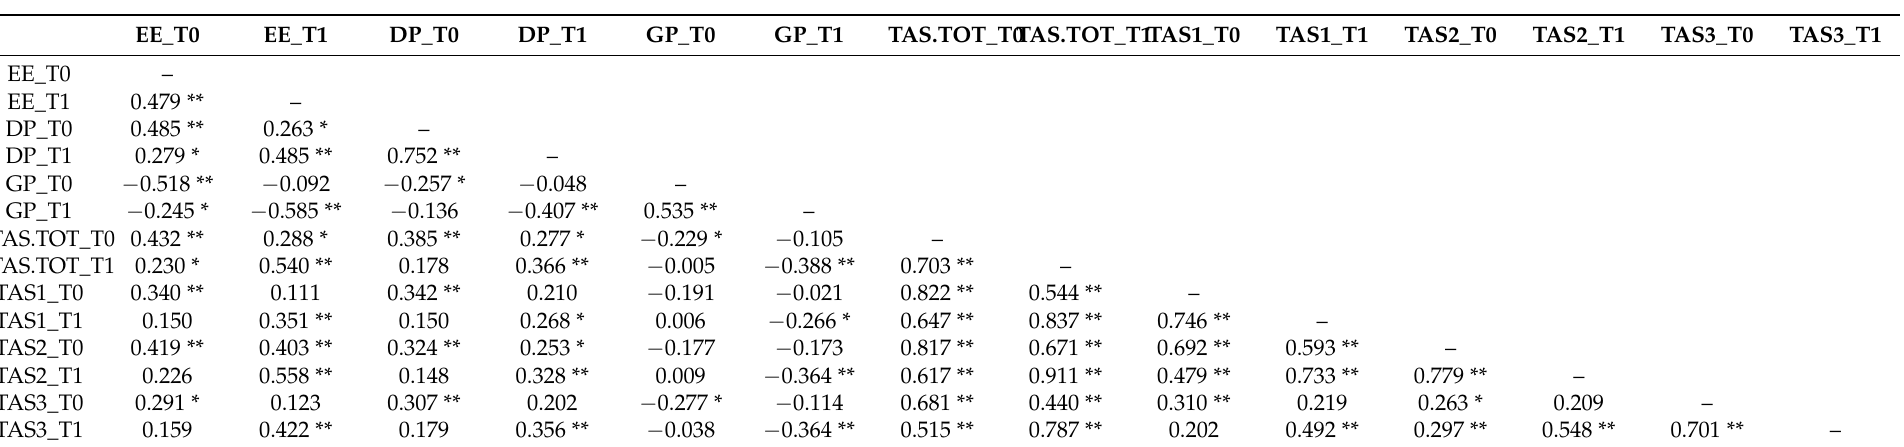
Table A3. Association between Maslach Burnout Inventory and Toronto Alexithymia Scale.